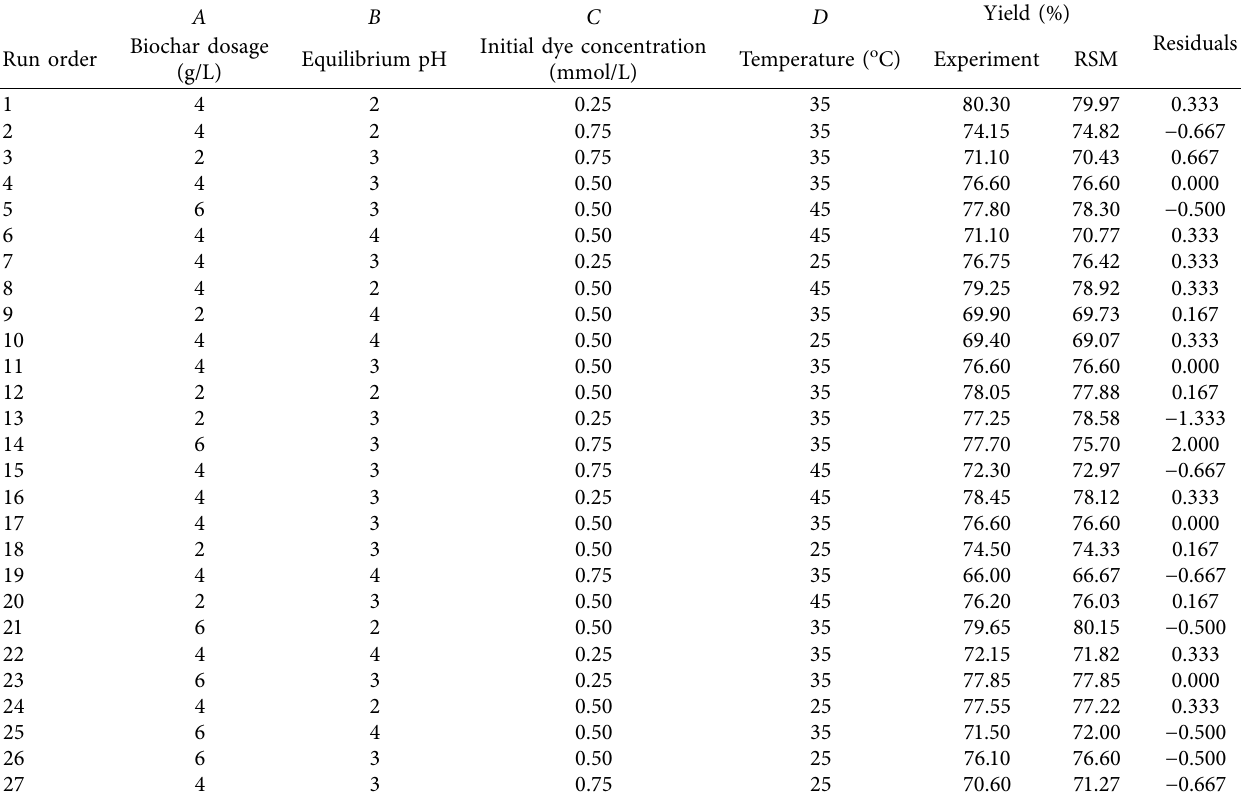
Table 3: Experimental and predicted responses of BBD with residual